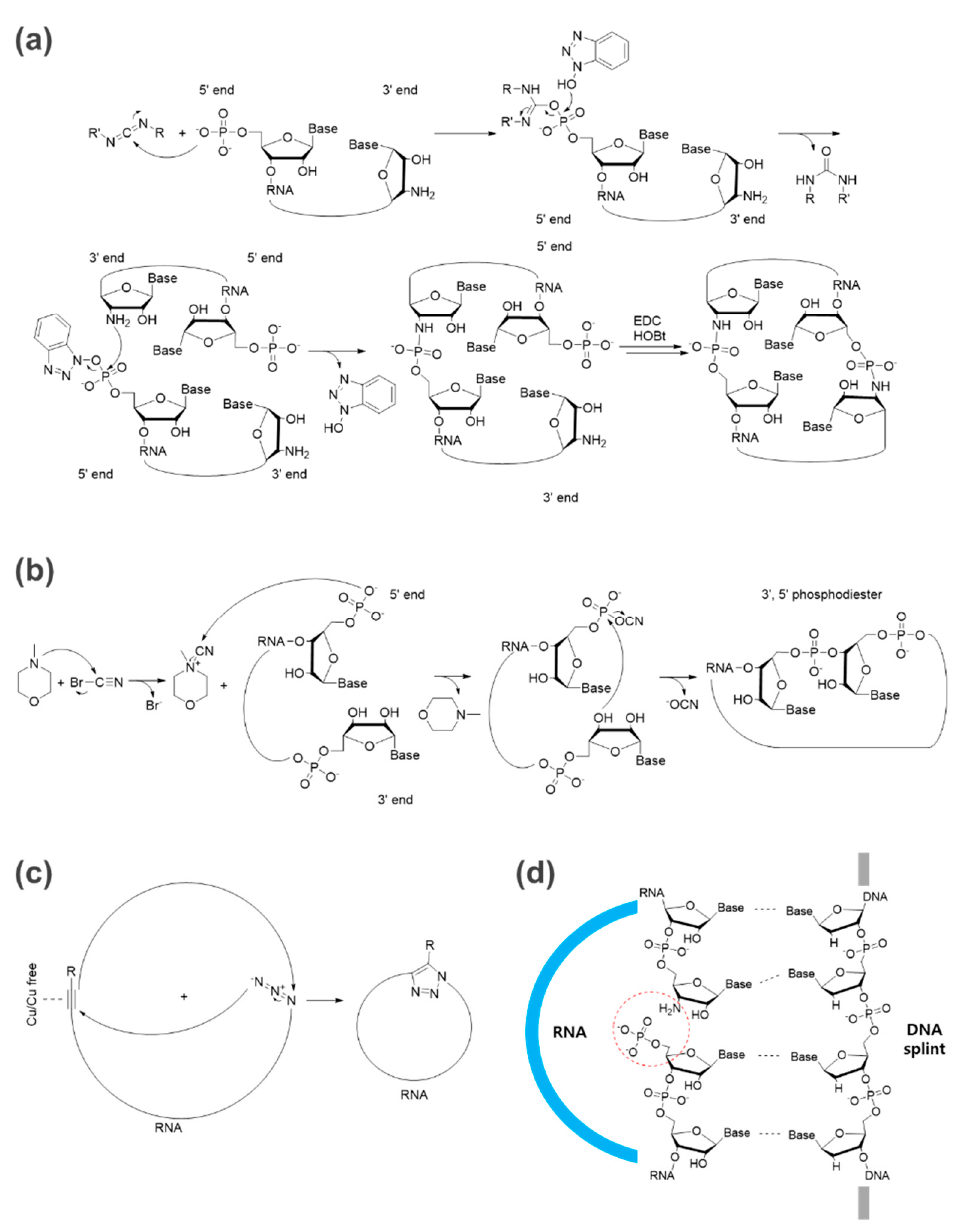
Figure 2. Representative chemical ‐ based methods for circRNA formation. ( a ) An example of an EDC ‐ based reaction [19]. The ligation for circRNA formation between 3 ′‐ amino ‐ modified RNA and 5 ′‐ phosphorylated RNA can be completed by 1 ‐ pot EDC/HOBt chemical synthesis with a DNA splint. ( b ) An example of a BrCN ‐ based reaction [20,21]. ( c ) An example of click chemistry using azide and alkyne for RNA circularization [22]. ( d ) DNA splint ‐ based ligation [23] for pre ‐ orientation of the 5 ′‐ and 3 ′‐ ends to be linked (red dotted circle, RNA in blue, DNA splint in gray).